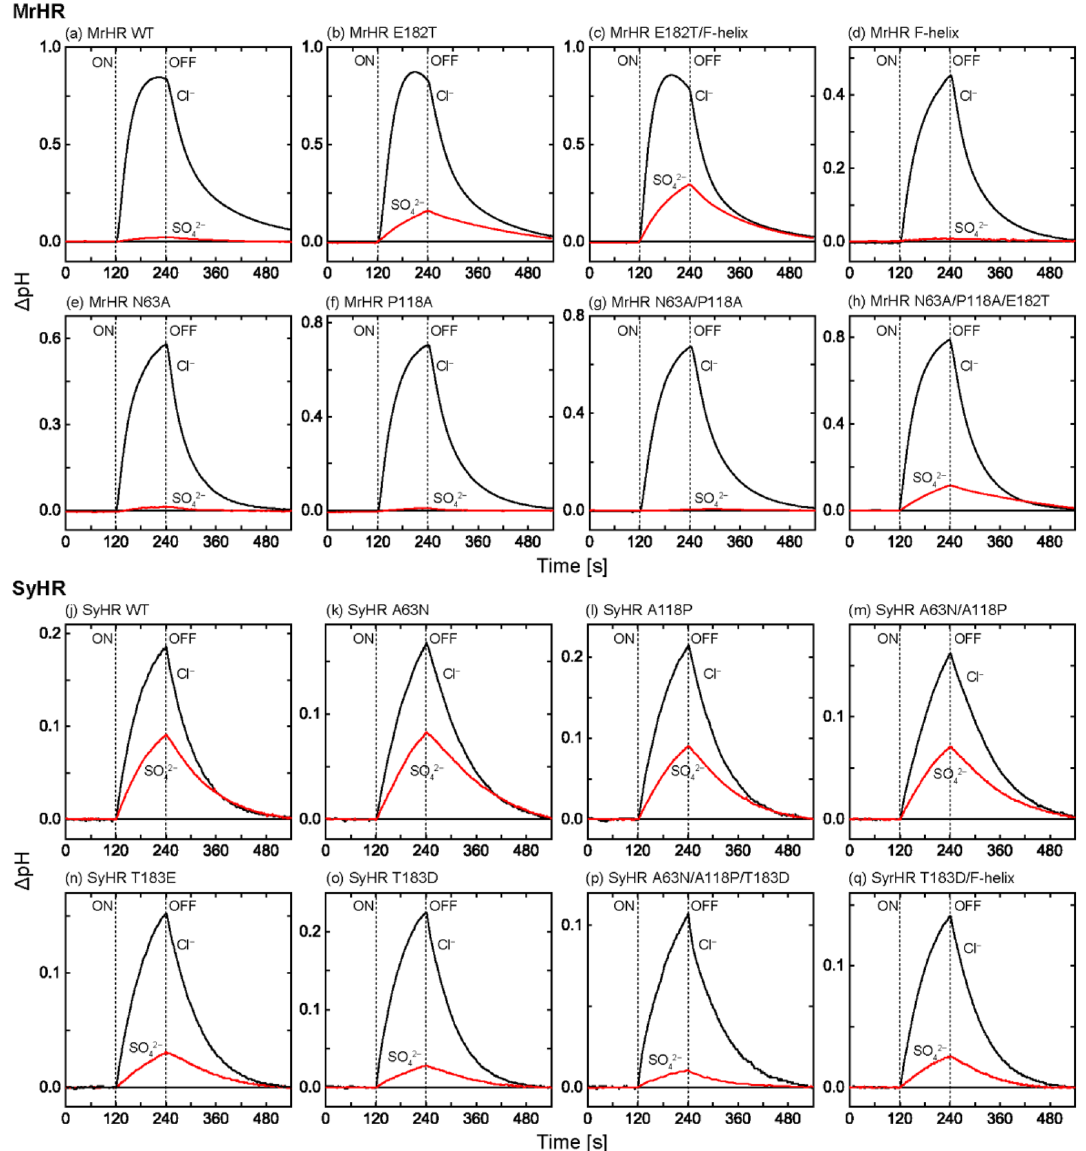
Figure 2. Anion pump activities of MrHR, SyHR and their mutants. The light-induced pH changes of E. coli suspensions were measured in the presence of 10 μM CCCP. The results for MrHR and the mutants are shown in the upper eight panels, and those for SyHR are shown in the lower panels. Each panel contains two time traces measured in the presence of 0.2 M NaCl (black line) and 0.2 M Na 2 SO 4 (red line). The initial pH values were 6.0–6.2. The vertical lines indicate the timing of illumination, whose intensity at 530 nm was set to 27.8 mW/cm 2